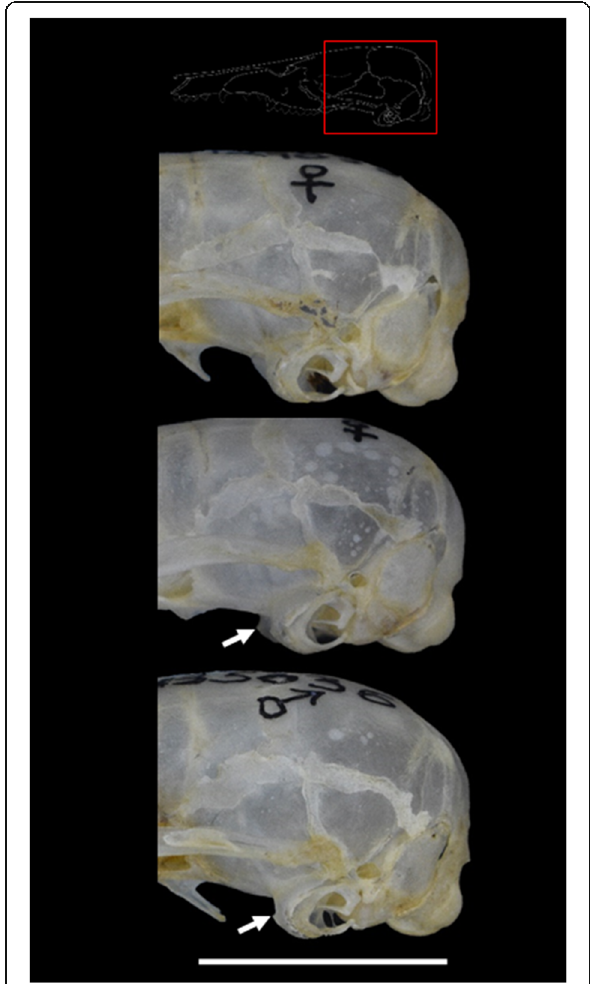
Fig. 4 Lateral view of the posterior portion of the crania of Rhyncholestes raphanurus Osgood, showing variable development in the alisphenoid tympanic process (astp). White arrows indicate the pointy anterior process of the astp (FMNH 129827 ♀ , FMNH 135036 ♂ ), which is not developed in FMNH 129833 ♀ .